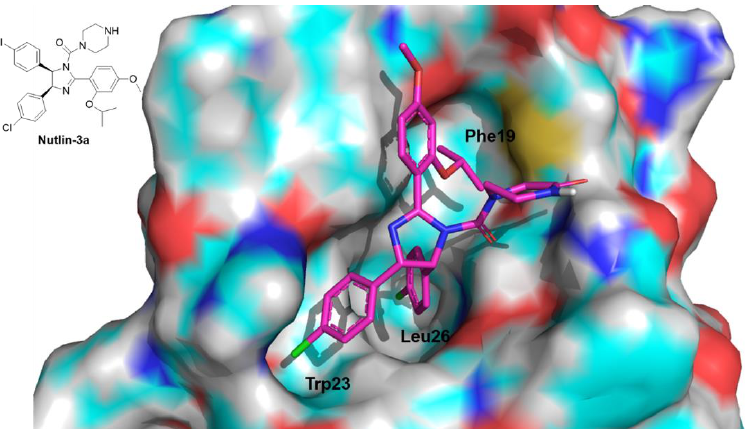
Figure 4. Crystal structure of the complex of Nutlin-3 with p53-MDM2 (Murine Double Minute 2) available on PDB under code 5C5A (in the chemical structure, carbon atoms are drawn in pink, nitrogen in blue, oxygen in red and chlorine in